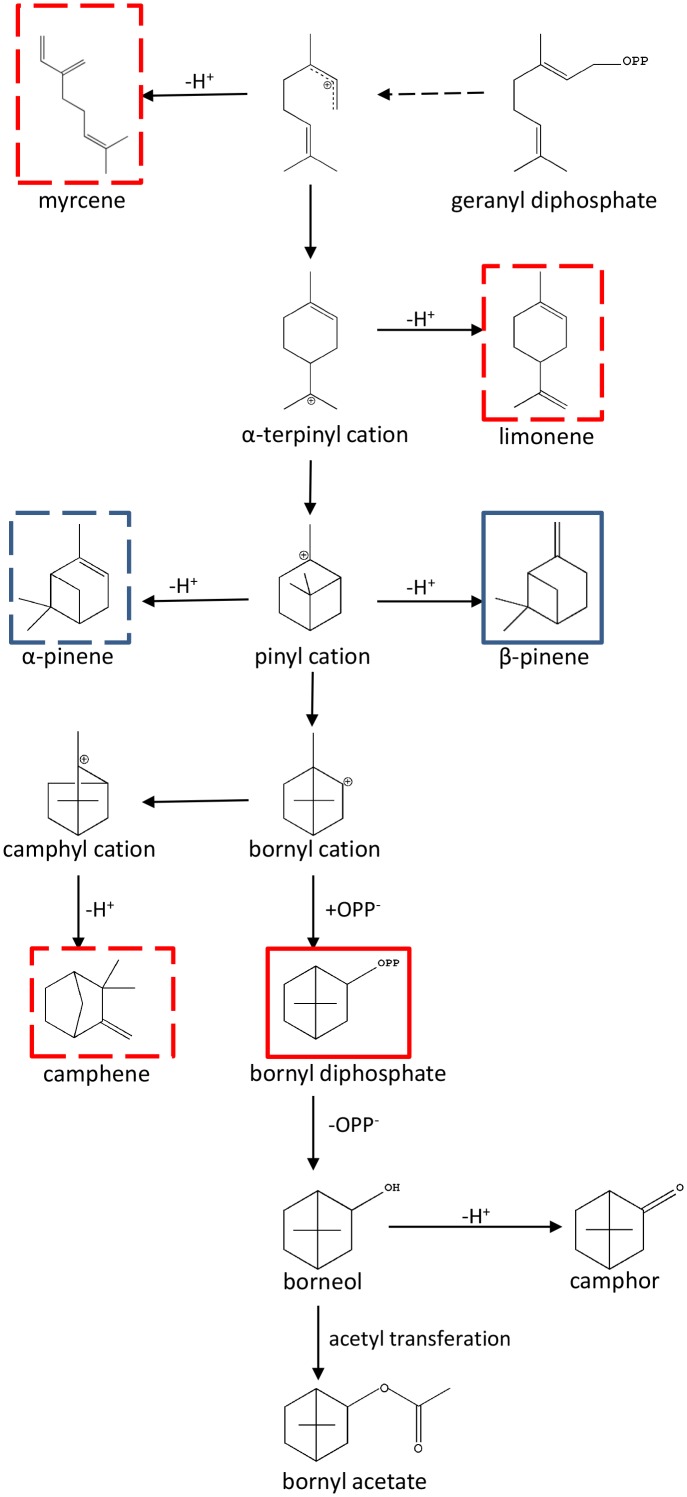
The direct and subsequent products of AvPS and AvBPPS and their downstream pathway. The pathway was adapted from Bohlmann et al. (1997) and Wise et al. (1998). The AvPS products were marked with blue frame and AvBPPS products were marked with red frame. Both main products were marked with full line and the sub-products were marked with dotted line.